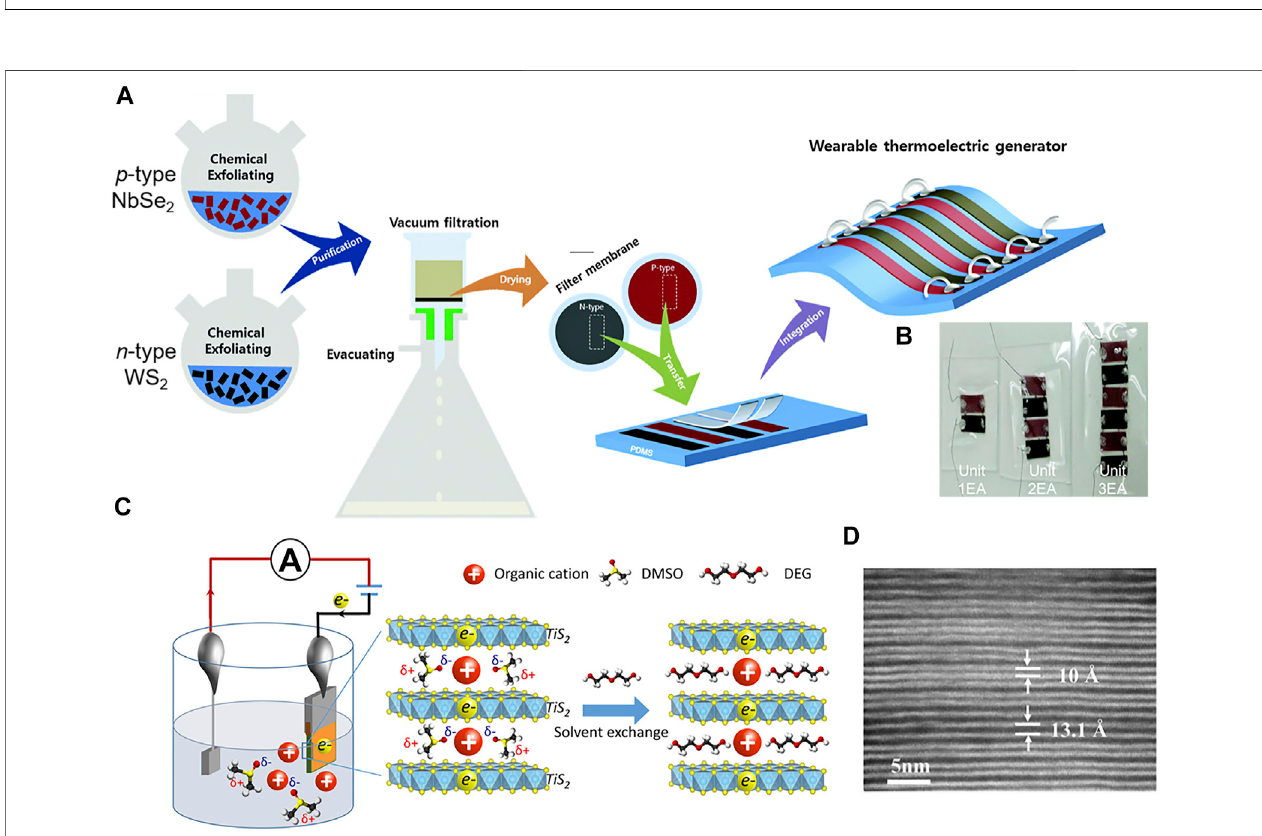
FIGURE 8 | (A) Schematic illustration of overall fabrication process of the nearable thermoelectric generator based on chemically exfoliated TMD nanosheets ( n -type WS 2 and p-type NbSe 2 ). (B) Photographic images of series- and parallel-connected thermoelectric generator units. Reprinted with permission from Ref. [138], Copyright 2015, Royal Society of Chemistry. (C) The facile chemical process used to synthesize TiS 2 -based hybrid inorganic/organic superlattices, which includes two- step electrochemical intercalation and solvent exchange processes. (D) HAADF-STEM images of one representative composition (TiS 2 (HA) 0.097 (PEG1000) 0.028 ), wherethebrightarearepresentstheinorganicTiS 2 layerandthedarkarearepresentstheorganicmolecules.ReprintedwithpermissionfromRef.[145],Copyright2015, American Chemical Society.